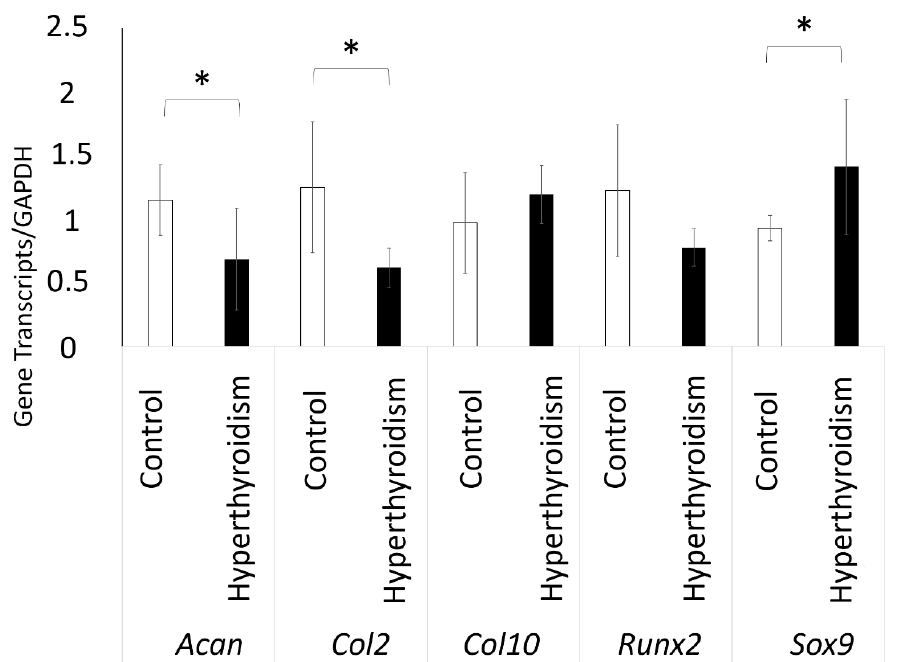
Figure 6. Expression of gene transcripts (mean ± standard deviation) of aggrecan ( Acan ), type II collagen ( Col2 ), collagen type X ( Col10 ), Runx2 and Sox9 by quantitative reverse-transcription PCR (qRT-PCR) in the 3D culture of chondrocytes extracted from the femoral epiphysis of control newborn rats and those with exposure to maternal hyperthyroidism at 21 days. * p < 0.05.